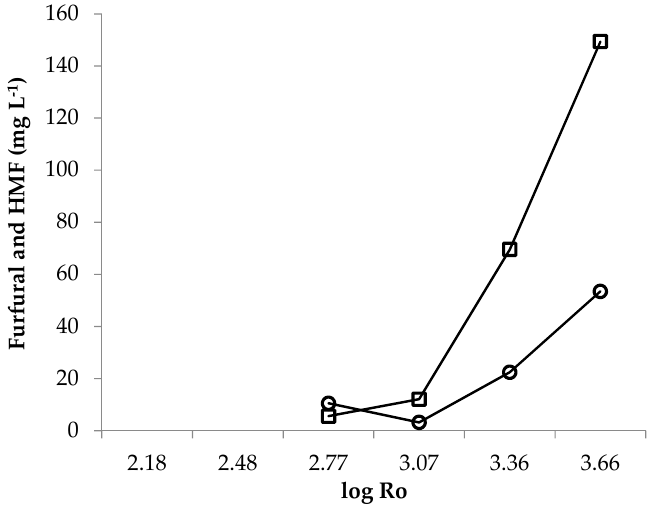
log Ro Figure 3. Concentration of HMF ( ○ ) and furfural ( □ ) according to the pretreatment severity (log Figure 3. Concentration of HMF ( ) and furfural ( (cid:3) ) according to the pretreatment severity (log Ro). Ro). Not detected for log Ro = 0.00, log Ro = 2.18 and log Ro = 2.48. (cid:35) Not detected for log Ro = 0.00, log Ro = 2.18 and log Ro =